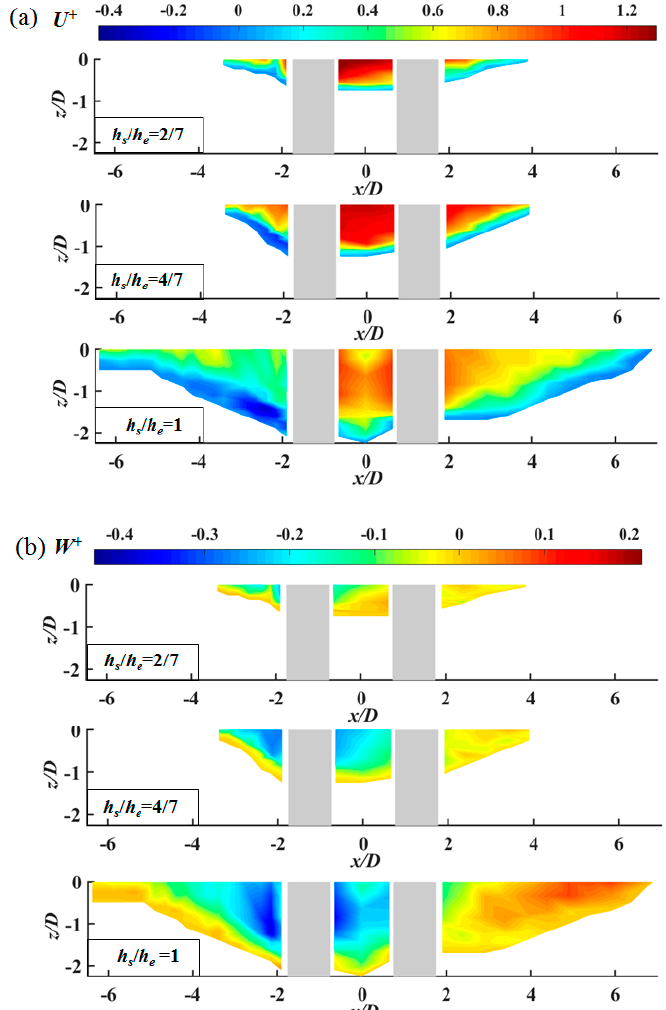
Figure 8. Velocity contours of ( a ) U + and ( b ) W + in the symmetry plane within developing scour holes.